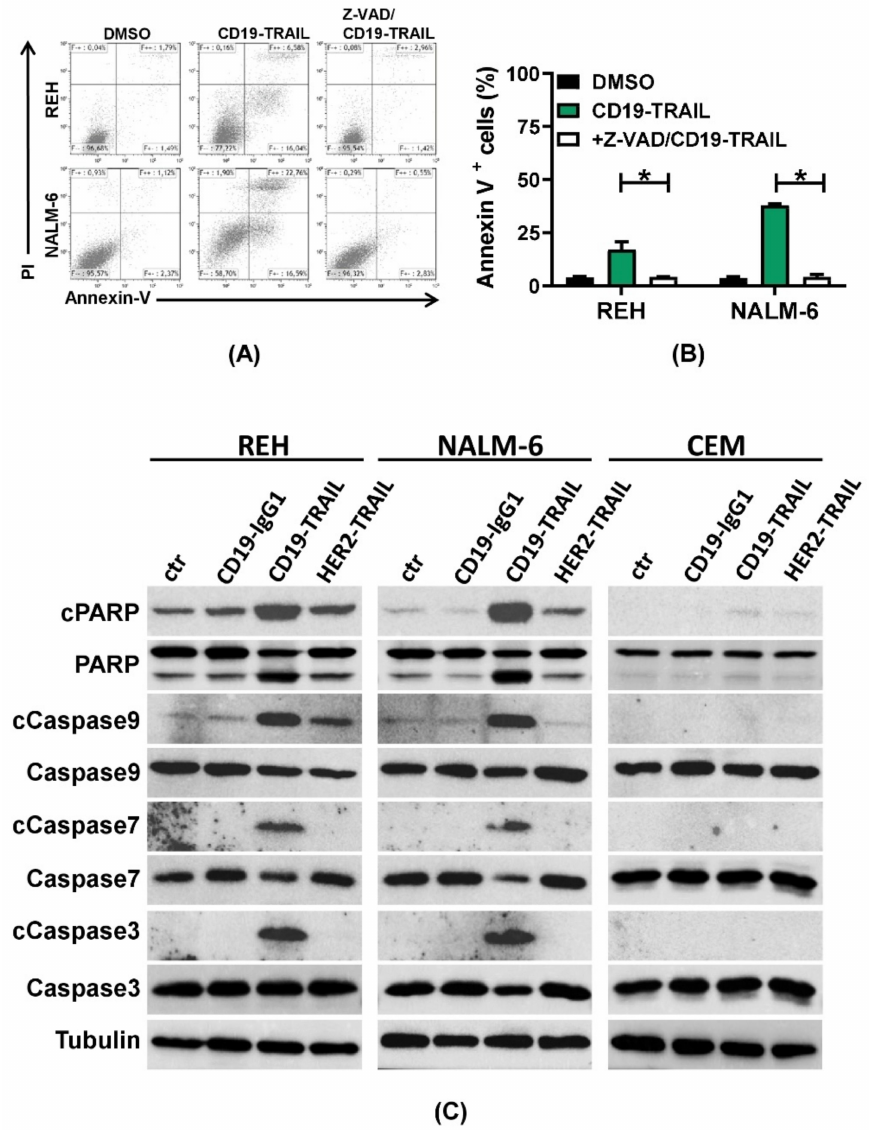
Figure 3. CD19-TRAIL kills ALL-cells via apoptosis induction: ( A , B ) REH and NALM-6 cells were pre-incubated with the pan-caspase inhibitor Z-VAD (50 µ M) for 1 h prior to incubation with CD19- TRAIL. DMSO served as negative control; ( A ) Representative histograms of flow cytometric analyses of AnnexinV and PI staining after 24 h and ( B ) mean values ± SEM of n = 3 independent experiments are shown, one-tailed Mann–Whitney Test, * p < 0.05; ( C ) Representative images of western blot analyses of the pro-apoptotic proteins Caspase 3, Caspase 7, and Caspase 9 and PARP as well as their cleavage (c) products (cCaspase3, cCaspase7, cCaspase9, and cPARP) in the cell lines REH, NALM-6, and CEM after treatment with 0.5 nM of CD19-IgG1, CD19-TRAIL, HER2-TRAIL, or medium (ctr) for 48 h. Tubulin served as loading